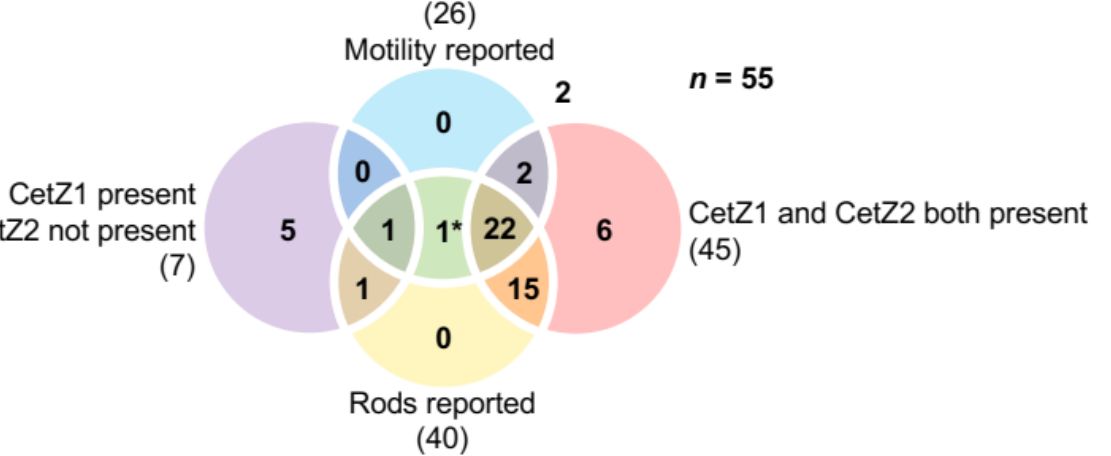
Figure 4. Correlations between CetZ1, CetZ2, rod shape, and motility in Halobacteria. Venn diagram showing overlapping circles representing the number of Halobacteria reported as motile or rod forming, having both CetZ1 and CetZ2 present, or having CetZ1 but not CetZ2 present (Table S1). The number of species showing co-occurrence of these characteristics is indicated where circles overlap. Species-specific data are provided in Figure S3. * The organism in this category is Natronomonas pharaonis (see Section 3.10, Figure S4A).